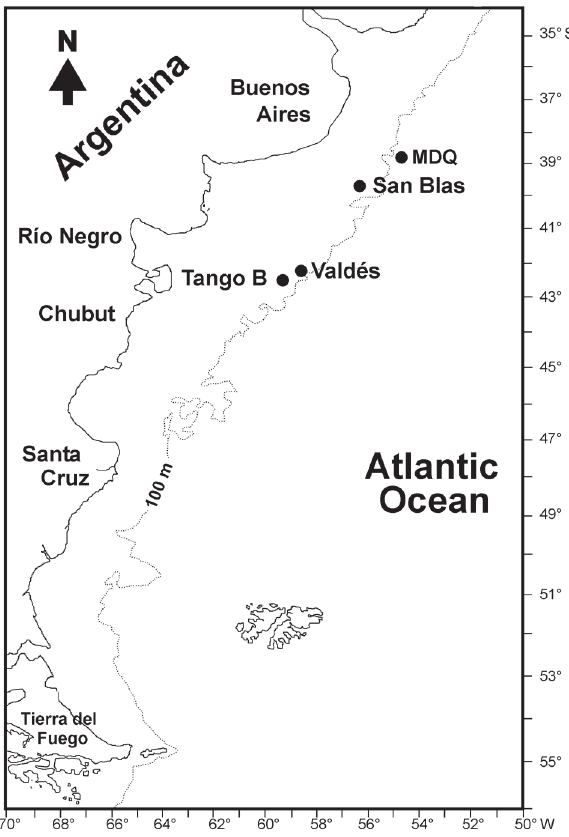
Fig. 1. – Distribution of Psychrochlamys patagonica beds sampled on the continental shelf off Argentina. The dotted line shows the 100 m